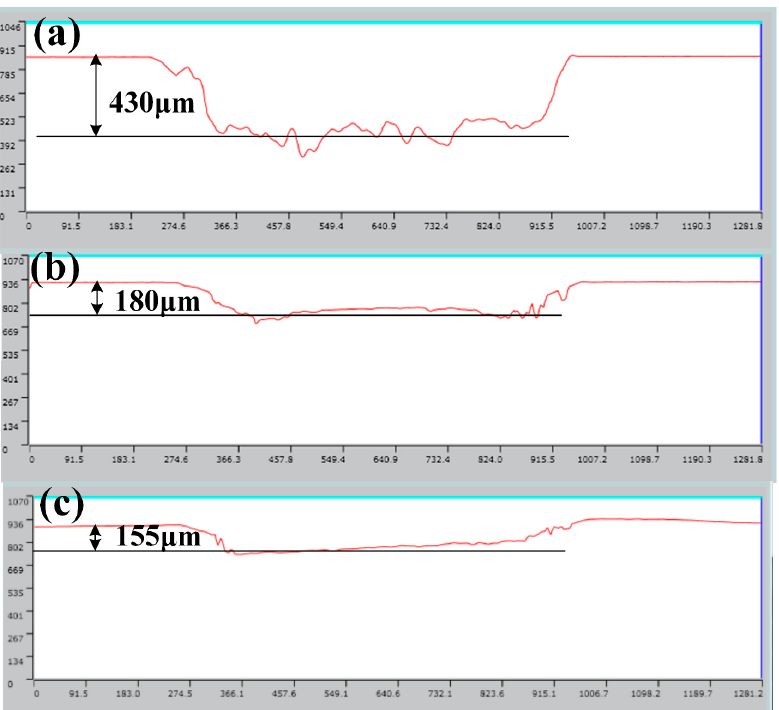
Figure 9. The depth of dimples; ( a ) the original depth of dimple, ( b ) the dimple depth of TCW sample after the test at high temperature, ( c ) the dimple depth of TCW sample after the test at room temperature.